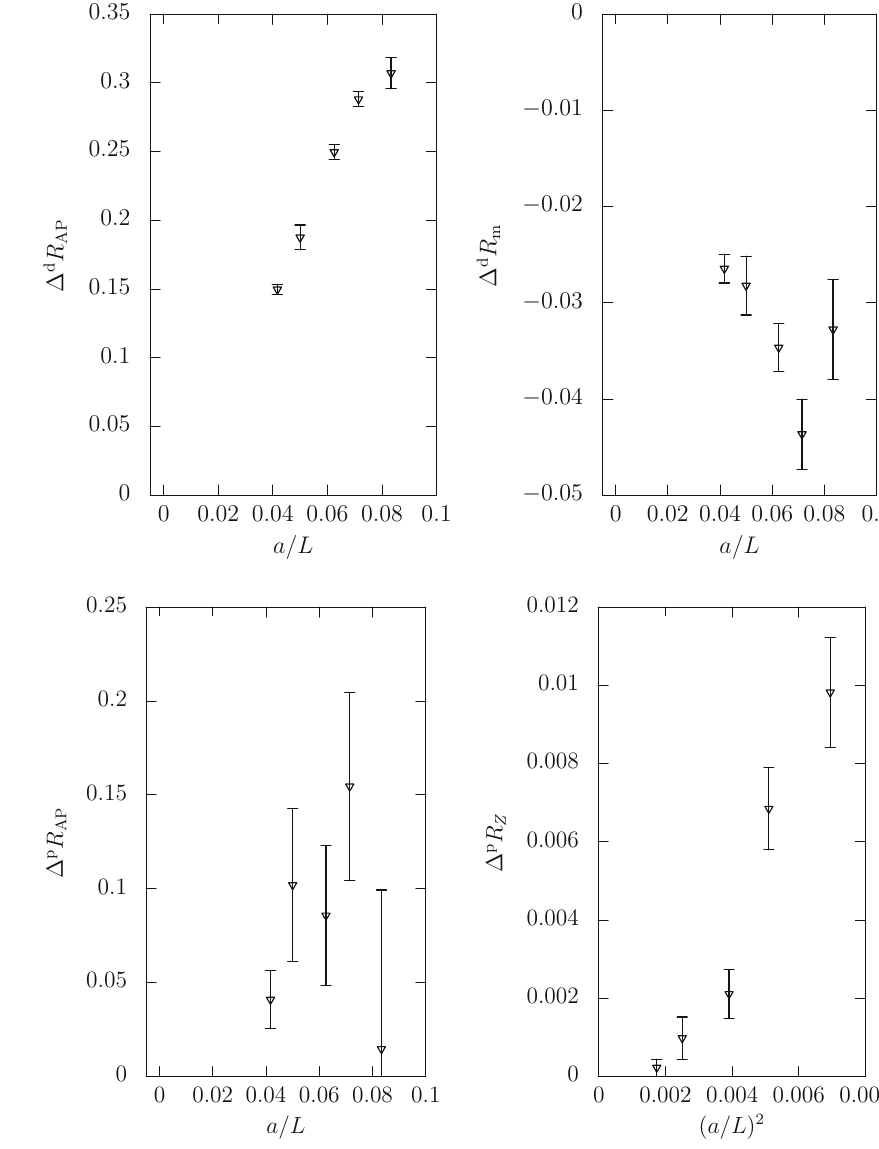
Fig. 5 O ( a ) ambiguity for R AP and R Z , originating from third- vs. fourth-degree polynomial fits